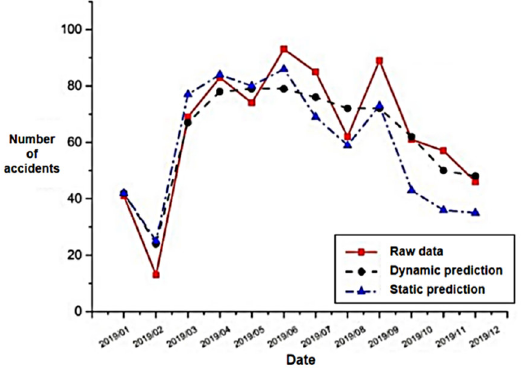
Figure 5. Monthly forecast results of housing municipal engineering production safety accidents in 2019 .